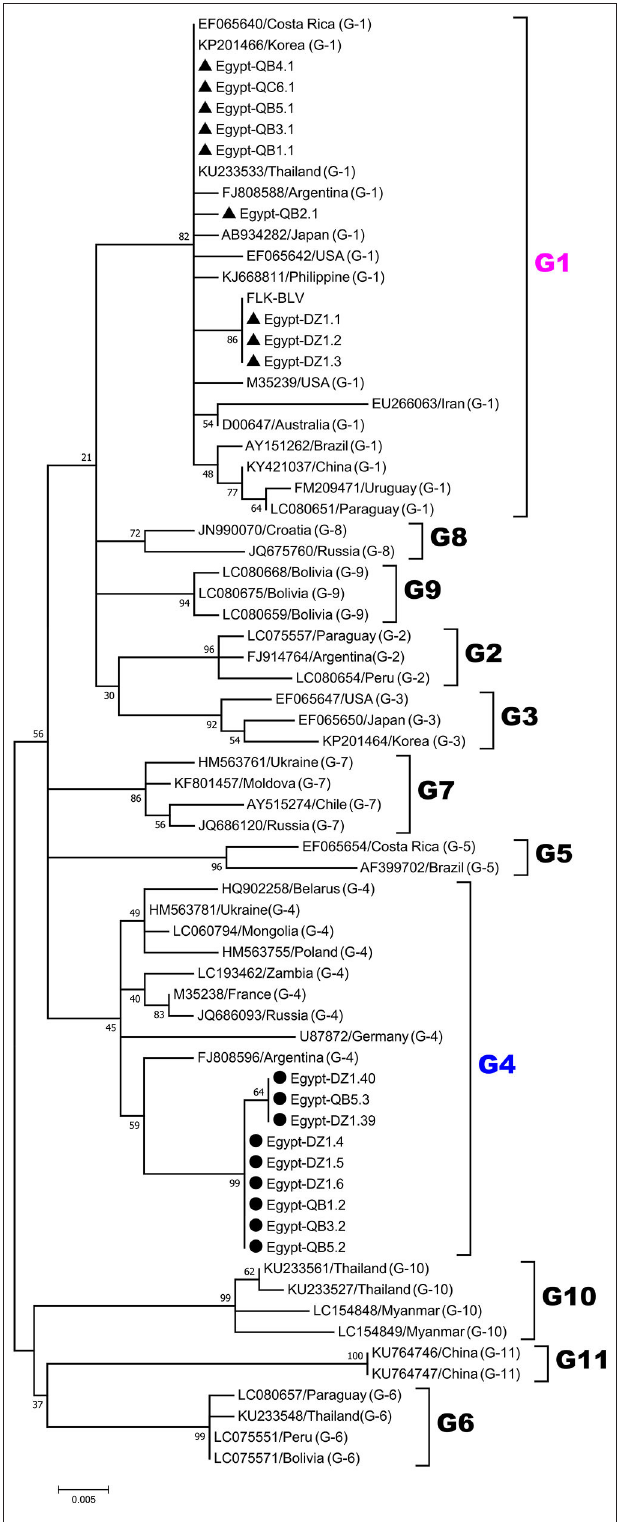
FIGURE 2 | Maximum likelihood (ML) phylogenetic tree based on 420-bp nucleotide of partial BLV env -gp51 gene sequences from the selected 18